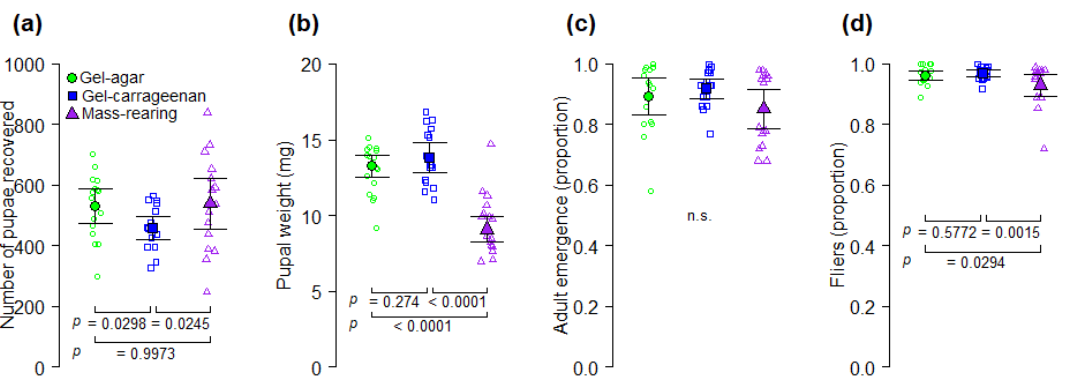
Figure 3. Effects of gel ‐ agar, gel carrageenan and mass ‐ rearing diets on ( a ) number of pupae recovered, ( b ) pupal weight (mg), ( c ) adult emergence (proportion), and ( d ) flight ability (proportion) of artificially reared A. ludens . Solid symbols indicate mean values and error bars show 95% CI; open symbols indicate jittered data points. The p values of Tukey contrasts among diets are shown within each figure panel; n.s. = no significant differences ( p > 0.05).